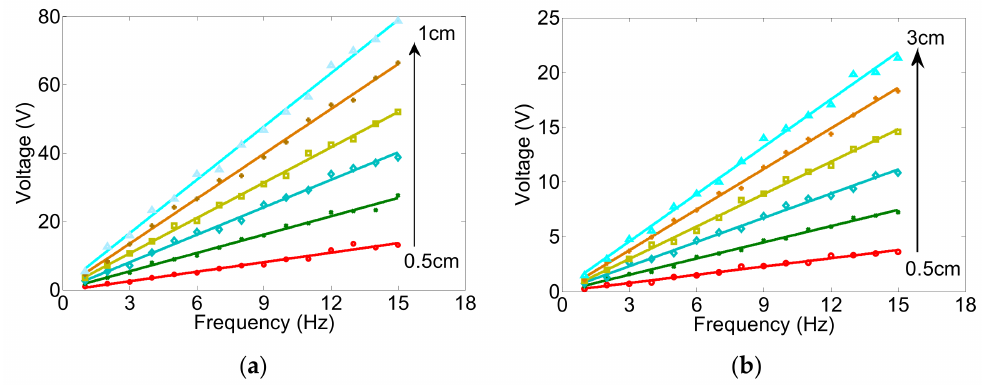
Figure 16. Output voltage. ( a ) Output voltage of LEMD. ( b ) Output voltage of LEM-DVA. The output voltage of LEMD and LEM-DVA is random in the actual driving process.